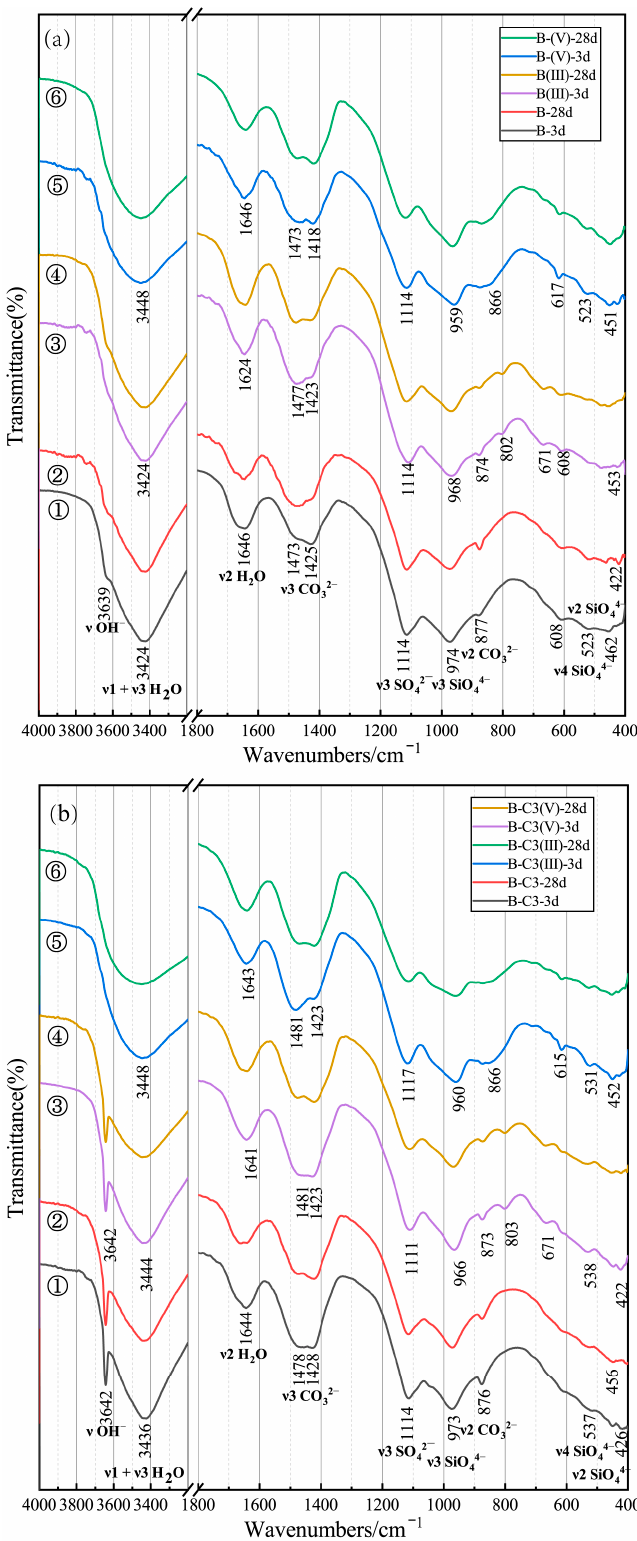
Figure 3. FTIR spectra of ( a ) ① and ② B sample, ③ and ④ B(III) sample and ⑤ and ⑥ B(V) sample; ( b ) ① and ② B-C3 sample, ③ and ④ B-C3(III) sample and ⑤ and ⑥ B-C3(V) sample. Nevertheless, some differences were observed in the infrared spectra of B(III) and B(V) samples. The weak band at 3639 cm − 1 in the B sample (Figure 3a 1 (cid:13) and 2 (cid:13) )